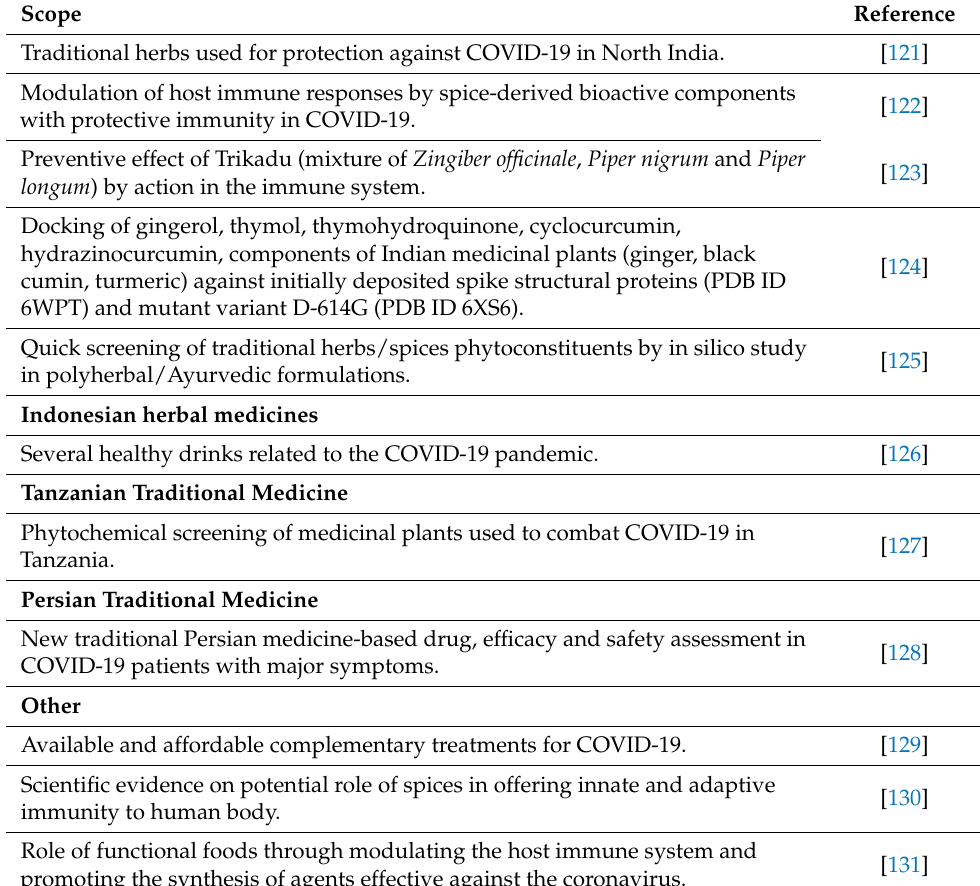
Table 4. Cont. Scope